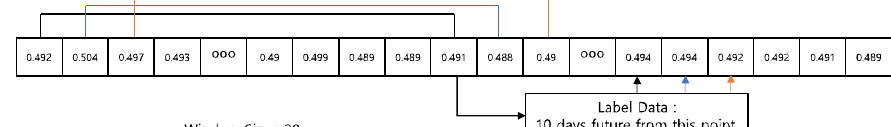
Figure 7. Training dataset.